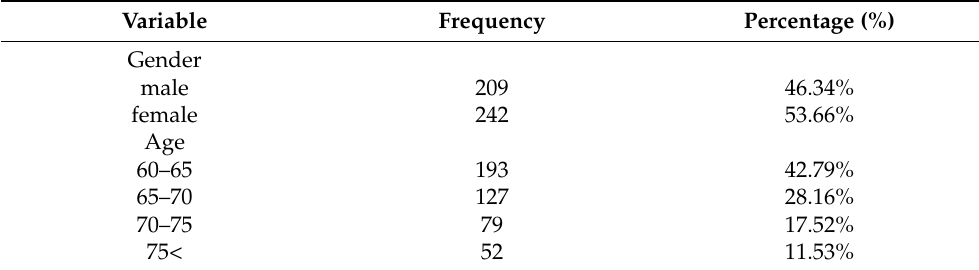
Table 1. Demographic characteristics of the